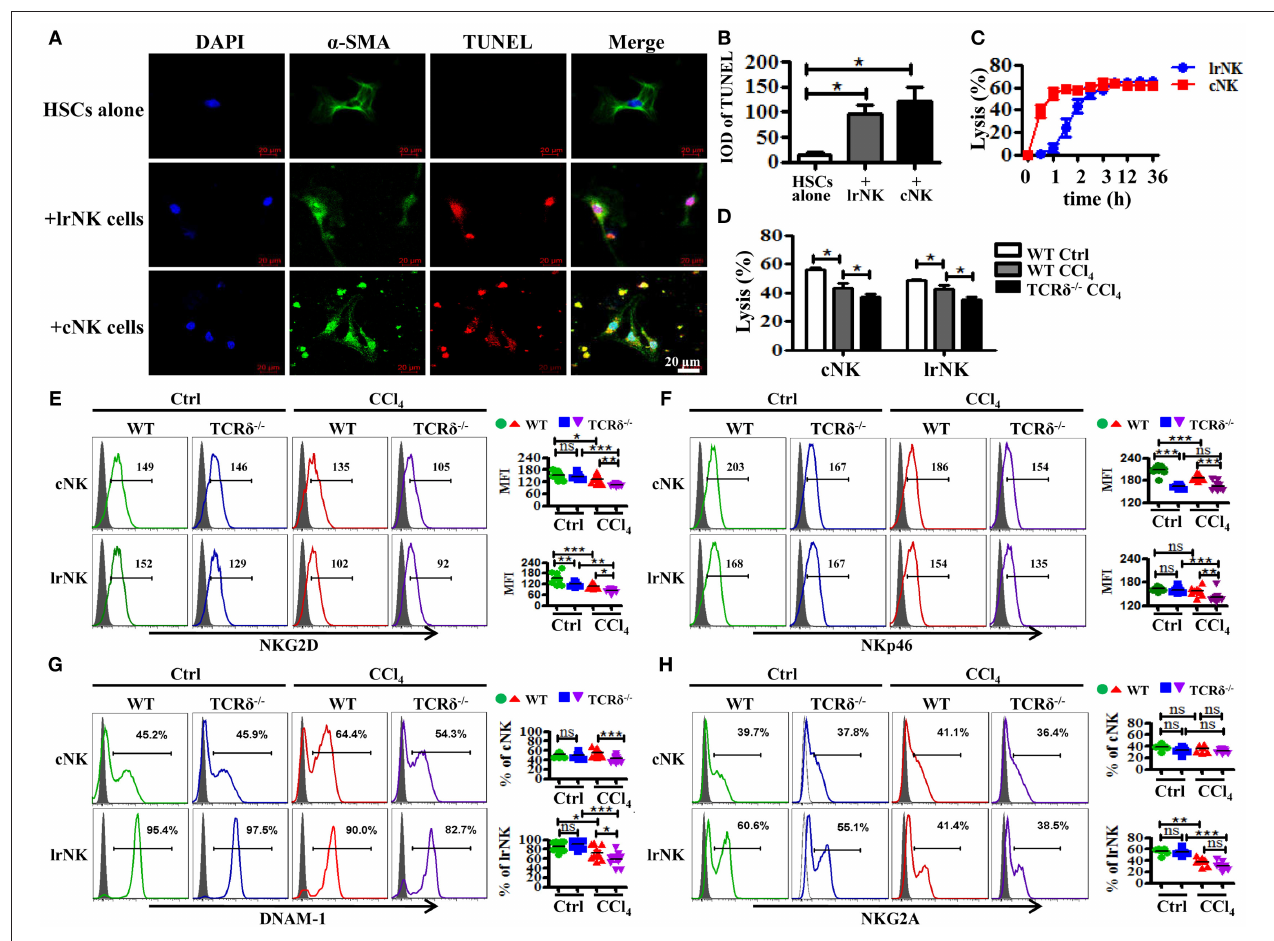
FIGURE 6 | γδ T cells deficiency attenuates the anti-fibrotic functions of both lrNK and cNK cells. (A) Culture-activated HSCs after co-culturing with lrNK cells ( + lrNK) or cNK cells ( + cNK) were stained with anti- α -SMA antibodies (green) and TUNEL (red) to identify apoptotic cells. Nuclei were counterstained with DAPI (blue). (B) Quantification of the expression of TUNEL as shown in (A) . (C) Activated HSCs were incubated with lrNK cells or cNK cells at an effector:target ratio of 2:1 for 36h, respectively. The time-lapse lysis (%) were calculated by counting the numbers of adherent live HSCs at different time points. (D) Hepatic cNK cells and lrNK cells isolated from corn oil-treated WT mice (WT Ctrl), CCl 4 -treated WT mice (WT CCl 4 ), and CCl 4 -treated TCR δ − / − mice (TCR δ − / − CCl 4 ) were co-cultured with activated HSCs at an effector:target ratio of 2:1, respectively. The cytotoxicity of hepatic cNK cells and lrNK cells against activated HSCs was measured using a LDH assay. (E–H) (Left) Representative histograms of NKG2D, NKp46, DNAM-1, and NKG2A expression on cNK cells and lrNK cells were determined by FACS . (Right) Statistical analysis is shown, n = 9–10. * P < 0.05, ** P < 0.01, *** P <